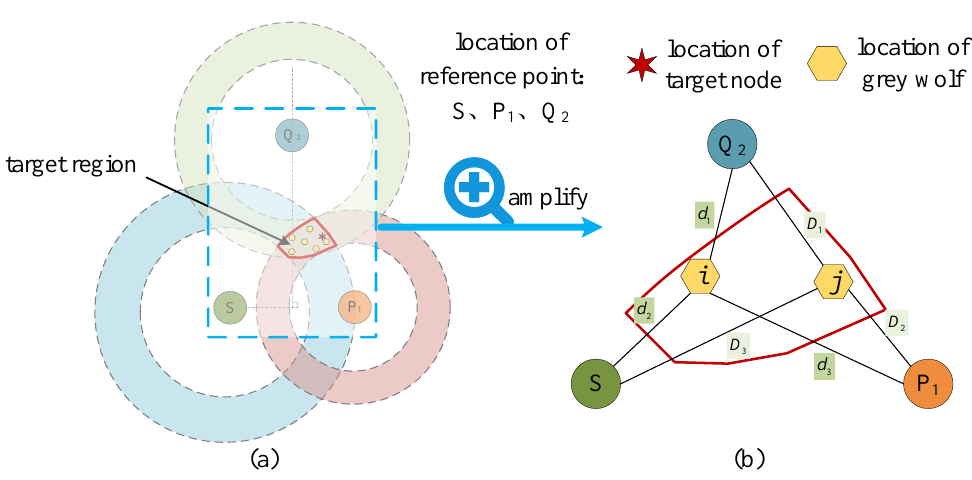
Figure 12. Optimizing the target node location using PSOGWO. ( a ) Optimizing the target node location. ( b ) The situation of equal fitness